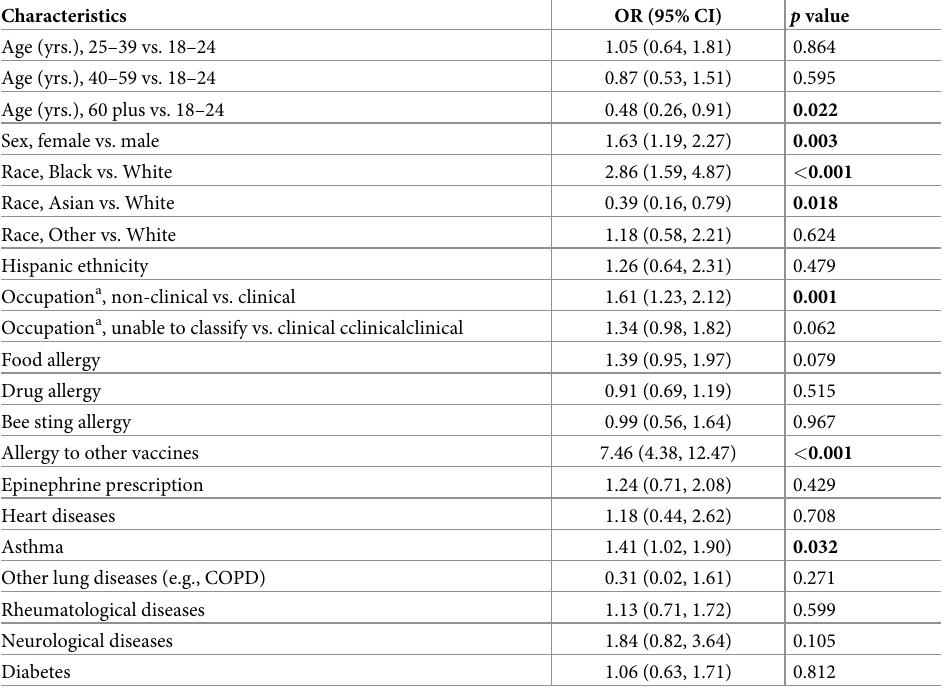
Table 1. Factors associated with vaccine